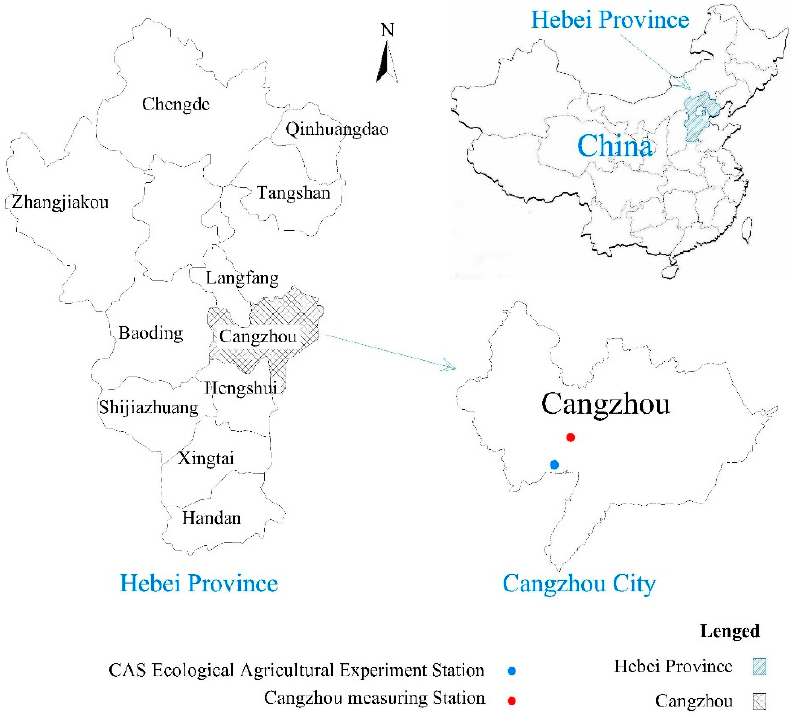
Figure 1. Location of the experimental and measuring stations in Changzhou, Hebei Province, China.